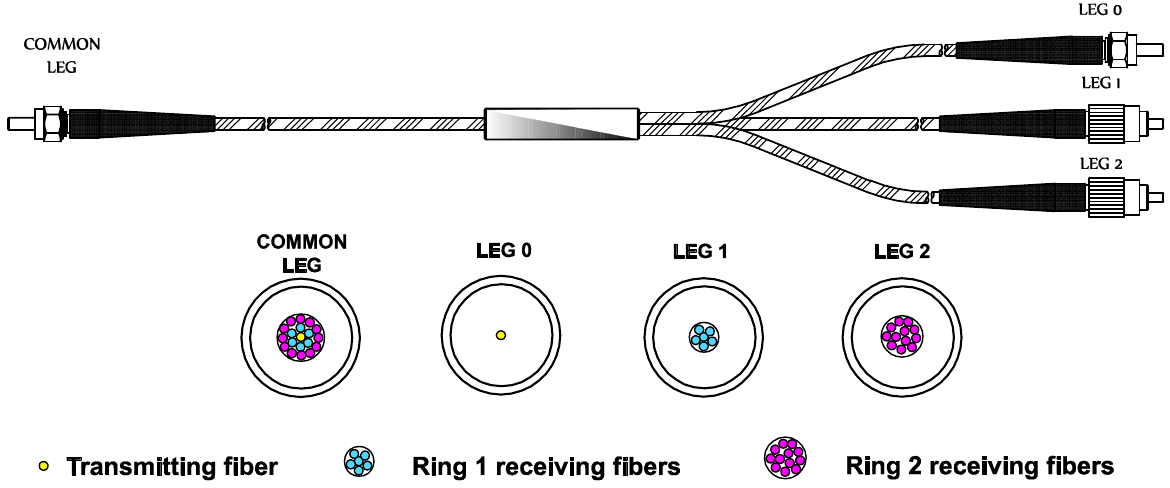
Figure 1. Trifurcated optical fiber bundle and legs cross-section.